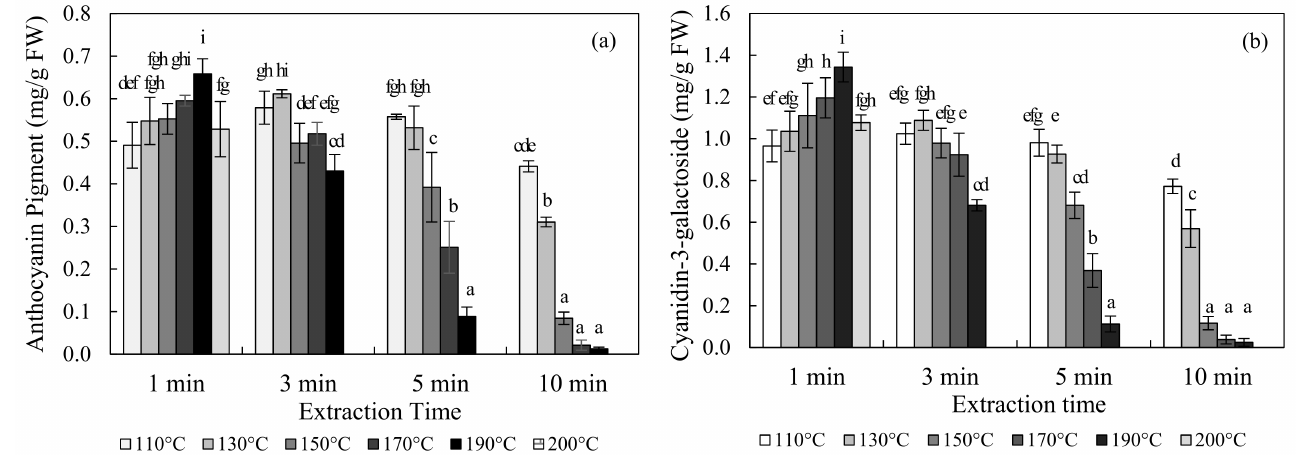
Figure 2. Anthocyanin pigment ( a ) and cyanidin-3-galactoside ( b ) concentrations of chokeberry extracts obtained using subcritical-water extraction (SWE) as analyzed by the pH differential method and high-performance liquid chromatography (HPLC) analysis. Means in bars with same letters are not significantly different according to Duncan’s test at p < 0.05. Data are mean and SD values ( n = 3). FW (fresh